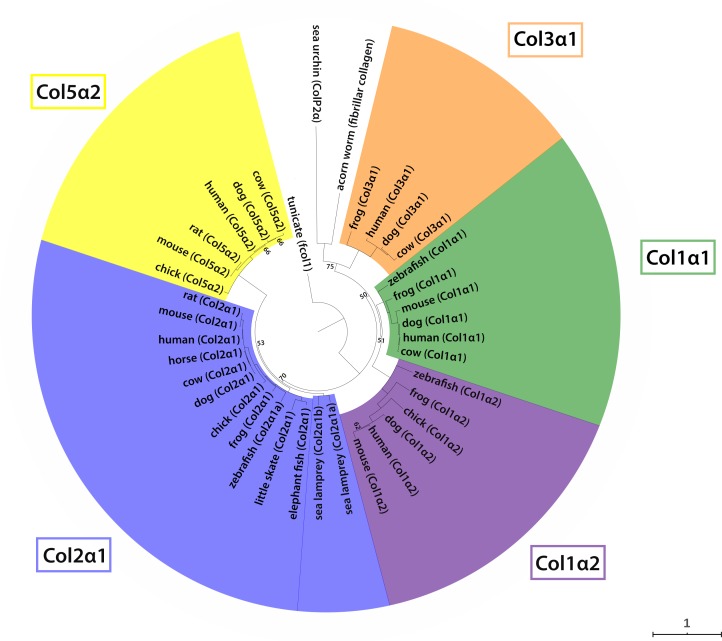
Phylogenetic analysis of vertebrate fibrillar collagens.Phylogenetic analysis of selected vertebrate fibrillar collagen amino acid sequences resolves five clades (Col3a1, Col1a1, Col1a2, Col2a1 and Col5a2) and confirms orthology of our newly reported little skate Col2a1 sequence (GenBank MT254563).